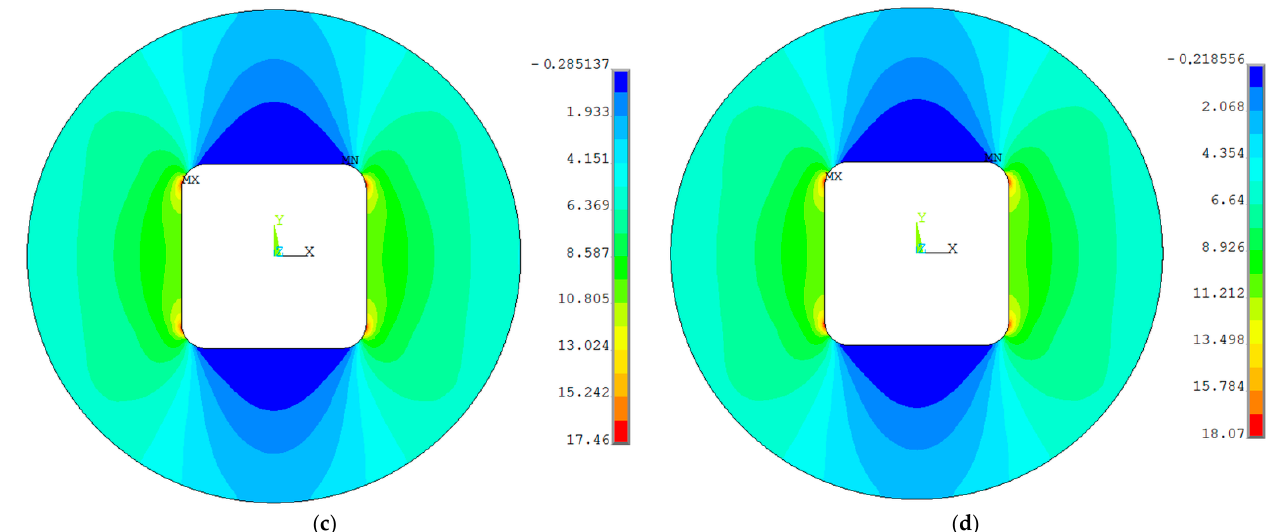
Figure 24. Distribution of tension stress σ y for circular patch in with R ov = 20 mm steel part under circular patch: for different fibre angle orientation: ( a ) θ = ± 45 ◦ ; ( b ) θ = 90 ◦ ; ( c ) θ = 0 ◦ ; ( d ) θ = 0 ◦ /90 ◦ .